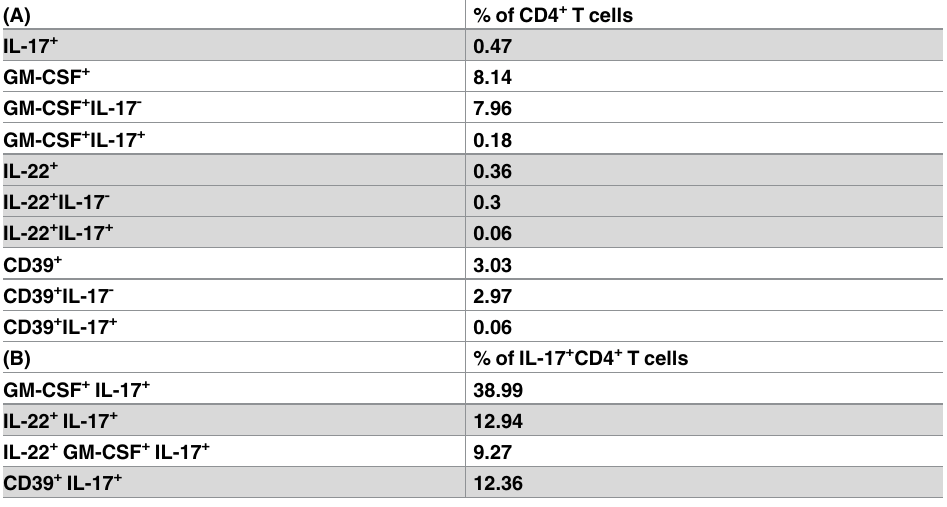
Table 4. Characterisation of GM-CSF, IL-22 and CD39expression by Th17 lymphocytes during MS relapses.